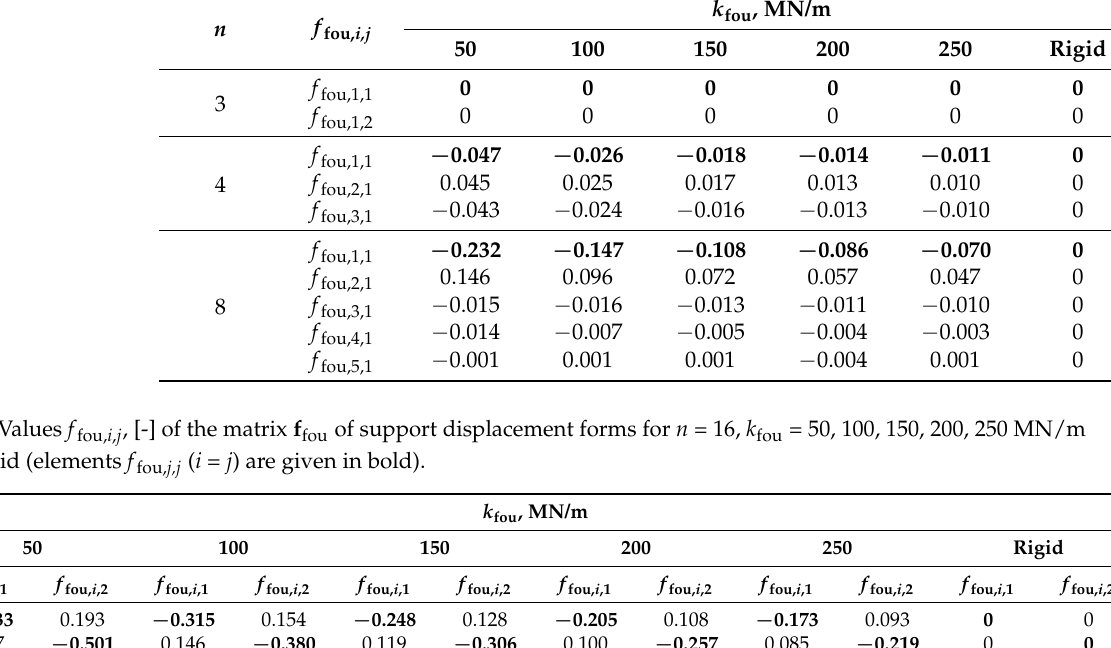
Table A11. Values f fou, i , j , [-] of the matrix f fou of support displacement forms for n = 3, 4, 8, k fou = 50,